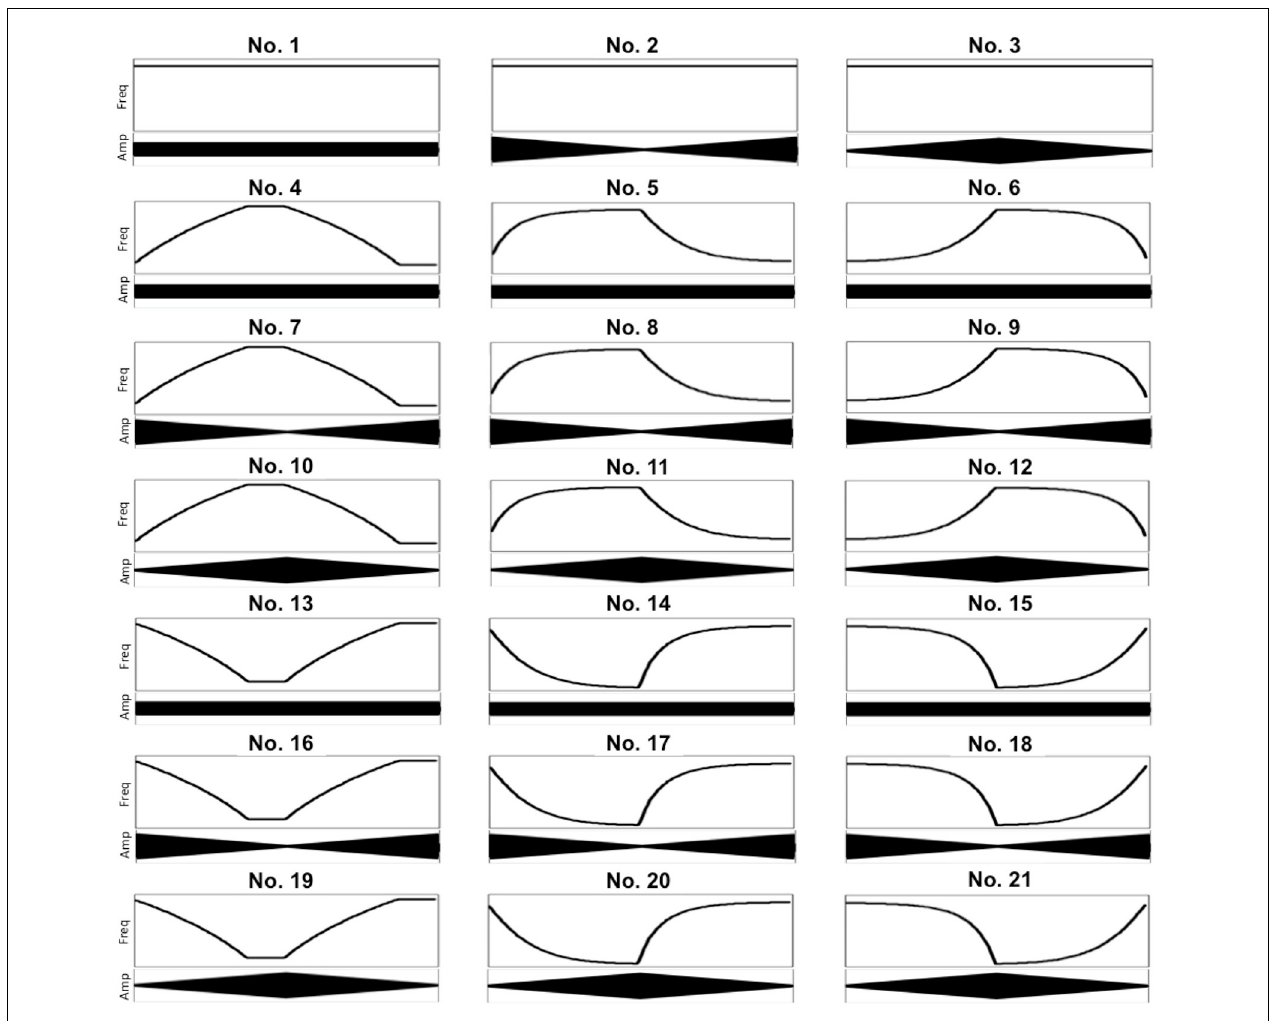
FIGURE 1 | Overview of frequency and amplitude contours of experimental sound stimuli. All x-axes represent time (length of stimuli: 8s). Highest/lowest frequency: 123.47/293.67Hz. Equal amplitude means